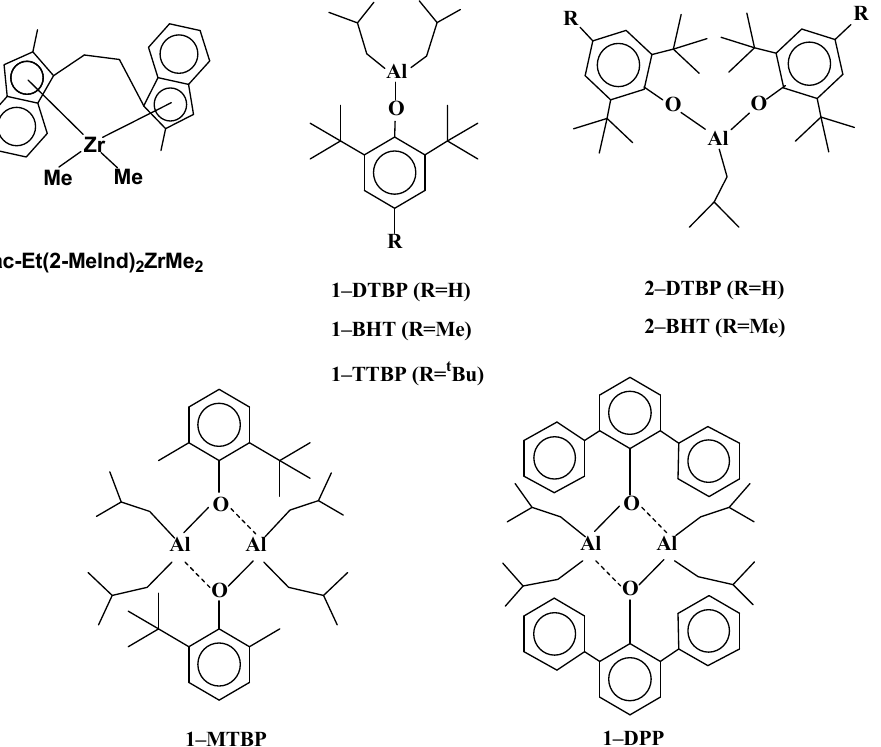
Figure 1. rac -Et(2-MeInd) 2 ZrMe 2 and isobuthylaluminum aryloxides used in the study.